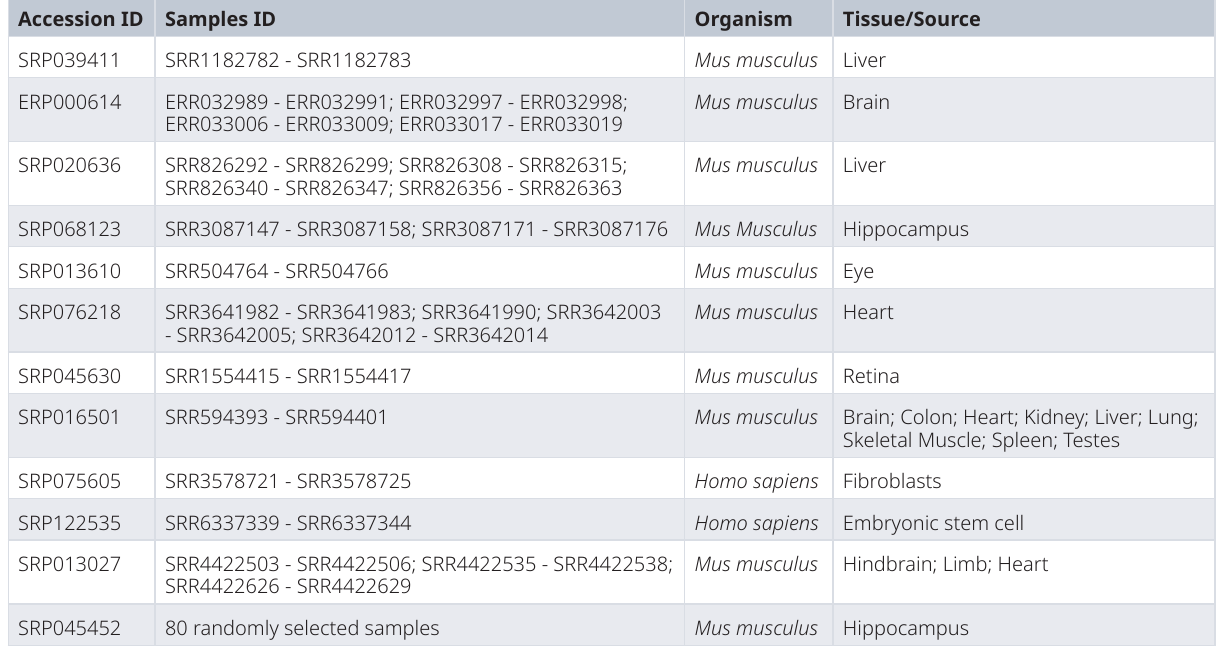
Table 1. List of datasets used for Scavenger testing and evaluation. The datasets are divided into three sections: 1. Datasets from selected non-reference mouse strain, 2. Normal (bulk) RNA-seq dataset from either human or mouse, and 3. Single-cell RNA-seq dataset from